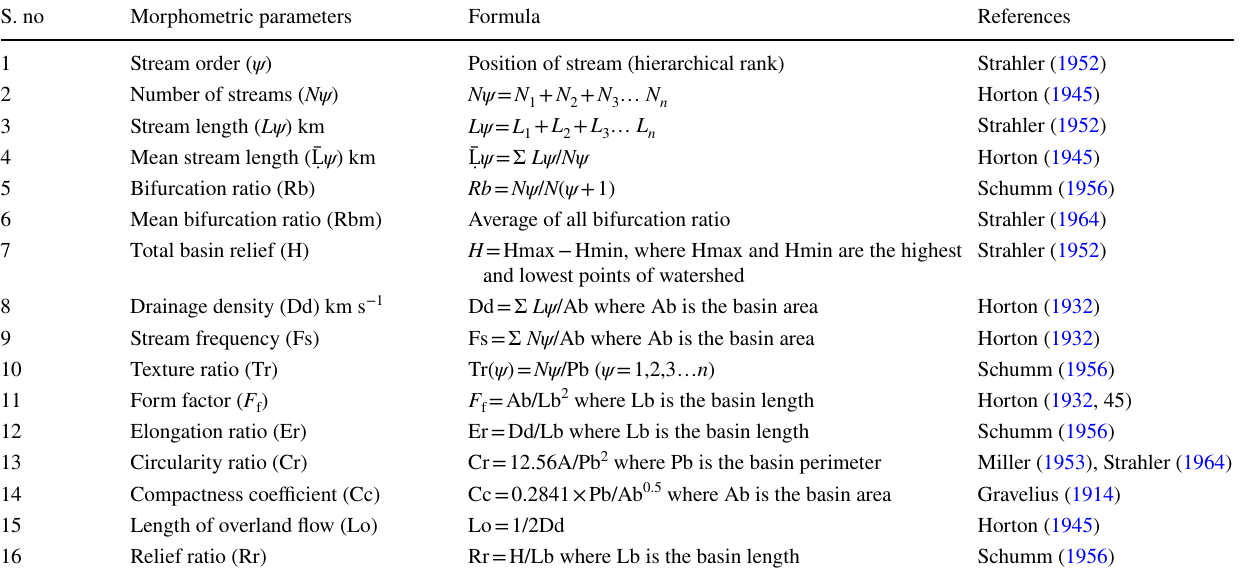
Table 1 Morphometric parameters, their formula and references S.